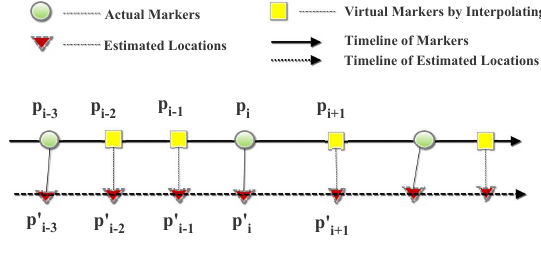
Figure 5: The accuracy evaluation method.